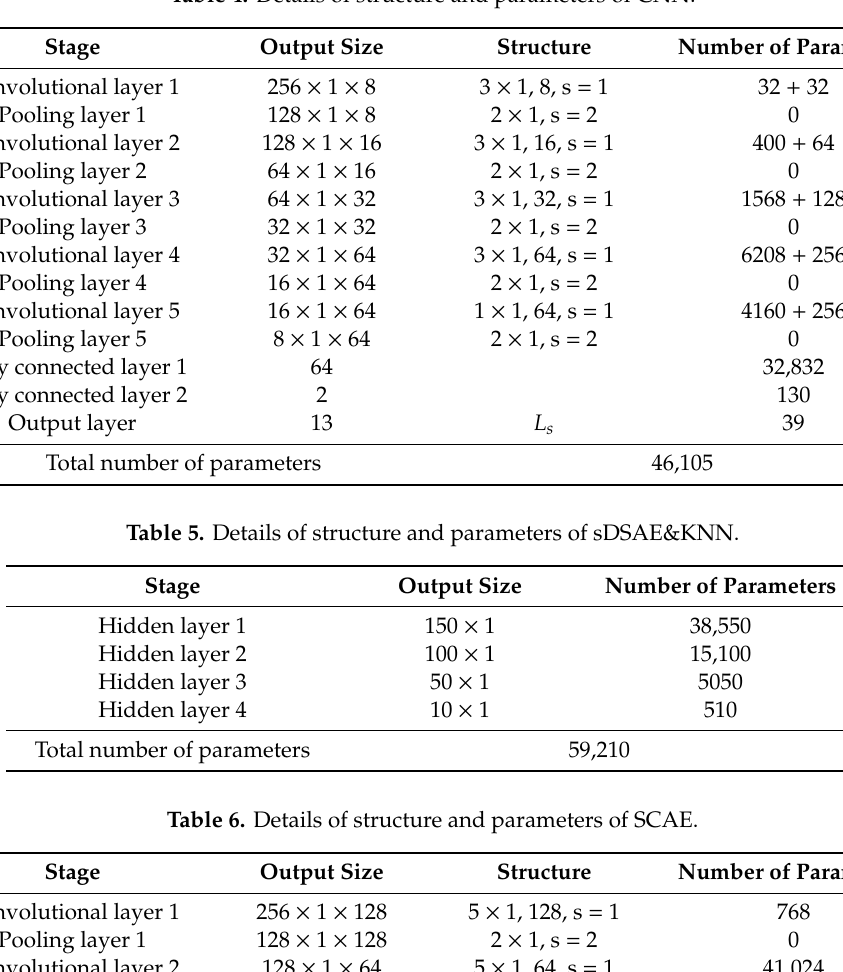
Table 4. Details of structure and parameters of CNN.